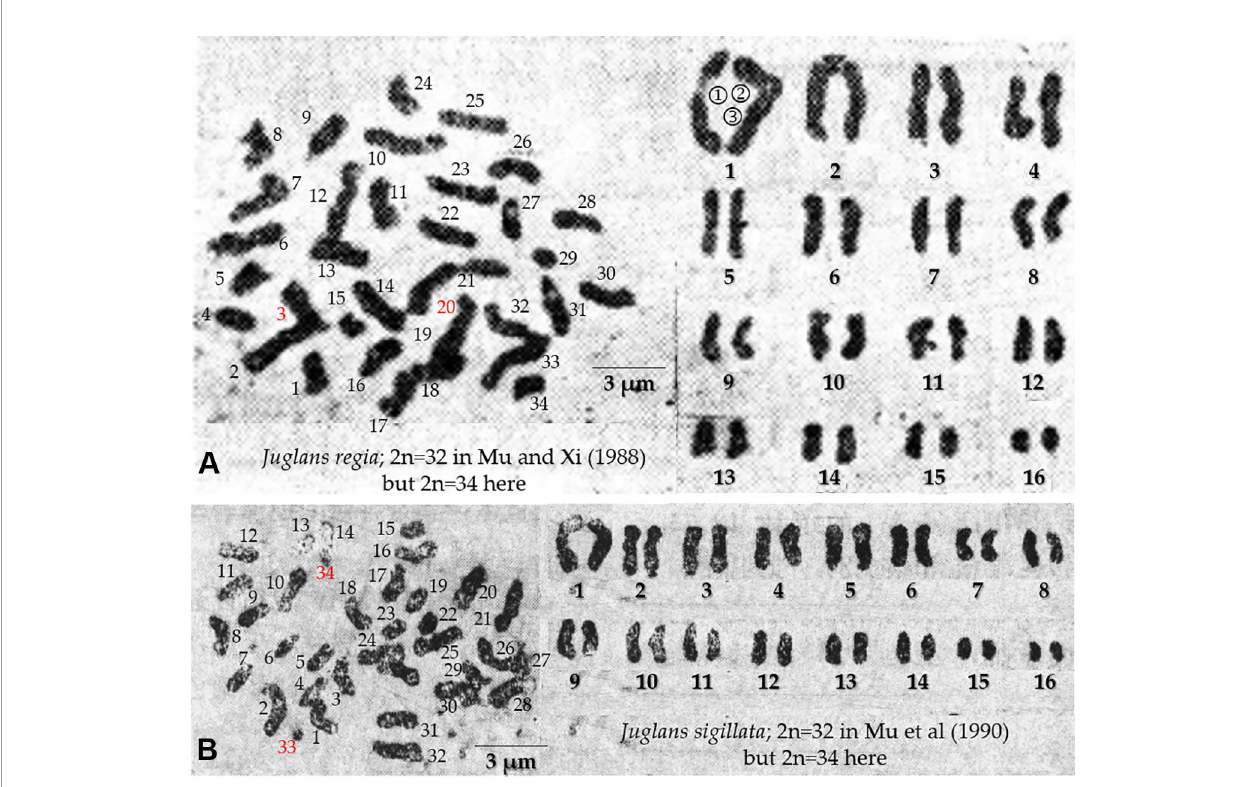
FIGURE 9 | Metaphase chromosomes of J. regia (A) and J. sigillata (B) . Mu and Xi (1988) reported 2n = 32 J. regia chromosomes, but 2n = 34 were counted here. The fi rst pair of chromosomes in (A) probably consists of three chromosomes, and the chromosomes with red numbers are likely disputed extra chromosomes. Mu et al. (1990) reported 2n = 32 J. sigillata chromosomes, but 2n = 34 were counted here. The chromosomes with red numbers in (B) are likely disputed extra